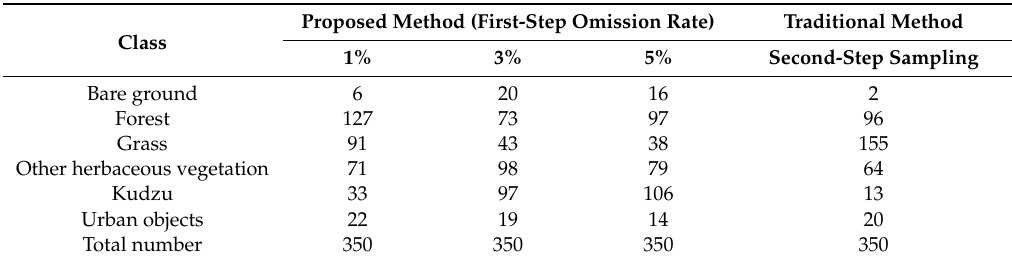
Table 4. Number of accurately labeled samples used for each run of model training for the second-step classification.